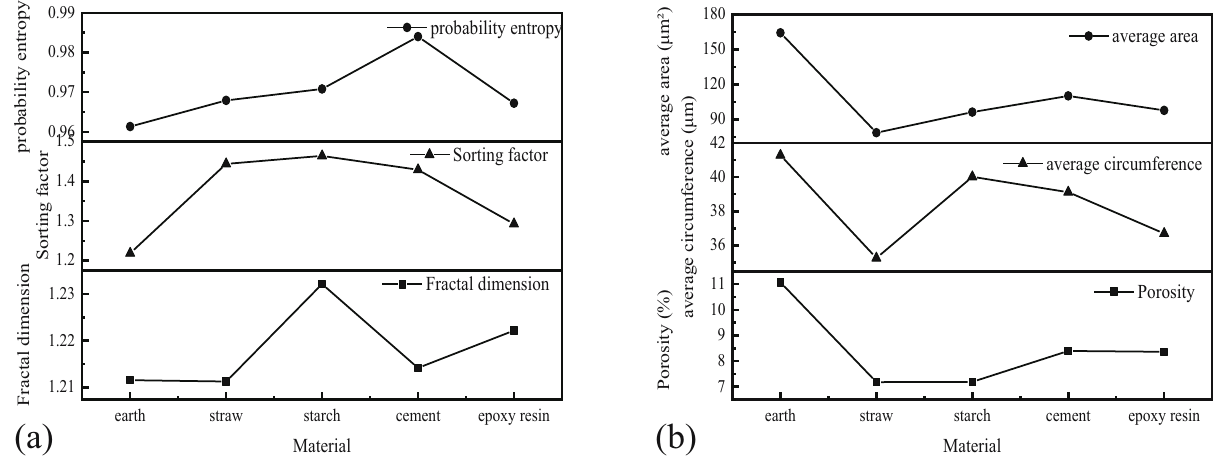
Figure 23: Parameter statistics: ( a ) fractal dimension, sorting factor, probability entropy; ( b ) porosity; average circumference; average